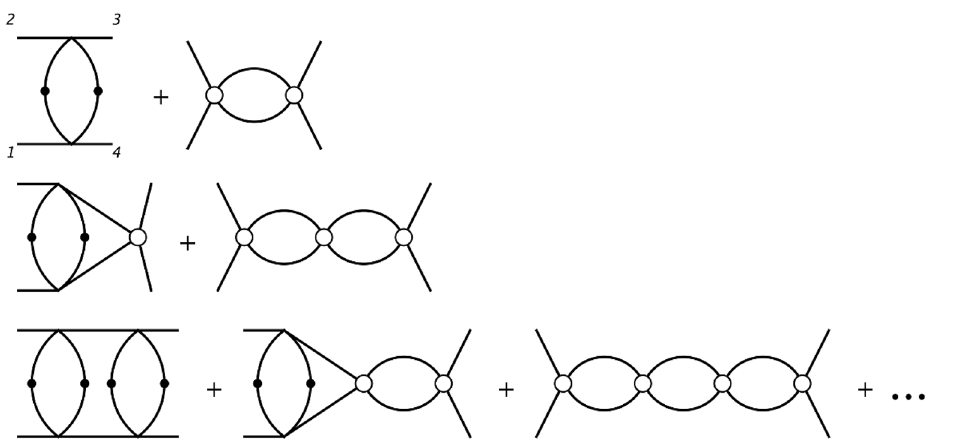
Figure 4 . Feynman diagrams contributing to the first orders of perturbative expansion of the A D =6 amplitude in the φ sector in the t channel. White blobs correspond to double-trace interactions, which in this particular case are equal to zero, so only the first diagram on the first and third rows gives non-trivial